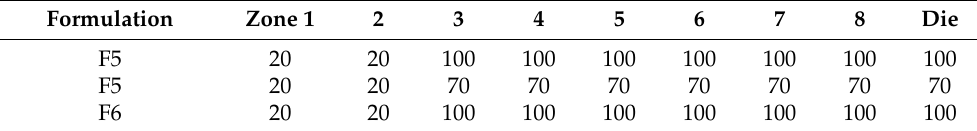
Table 3. Temperature profiles across the different zones of the extruder barrel ( ◦